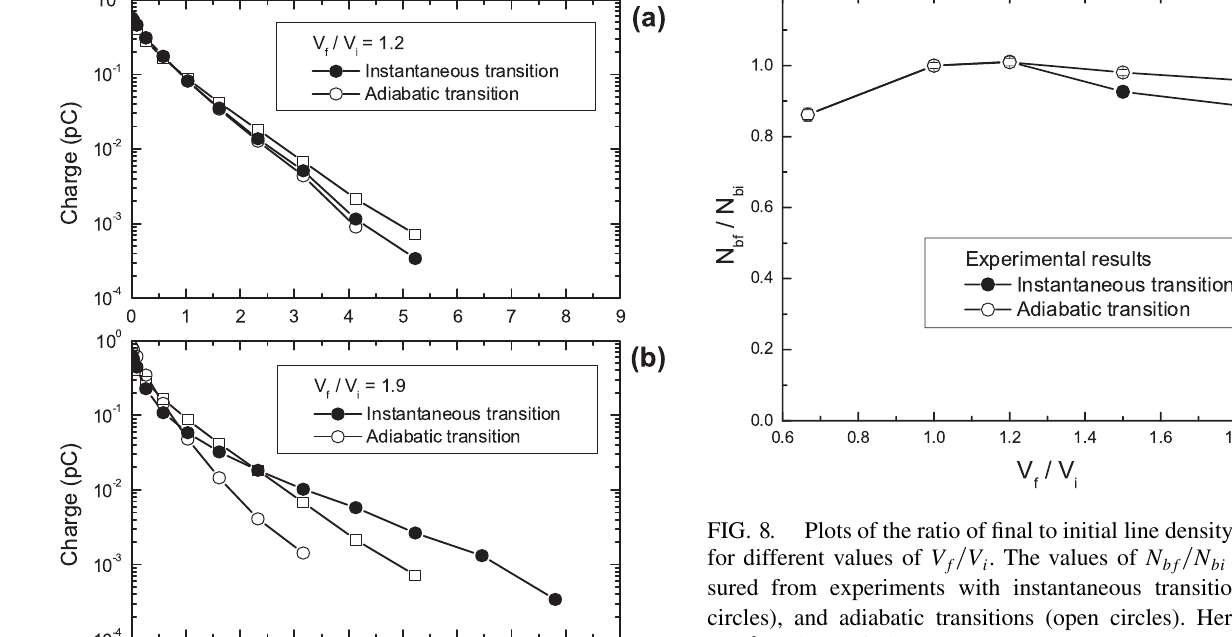
=V . The values of N f i